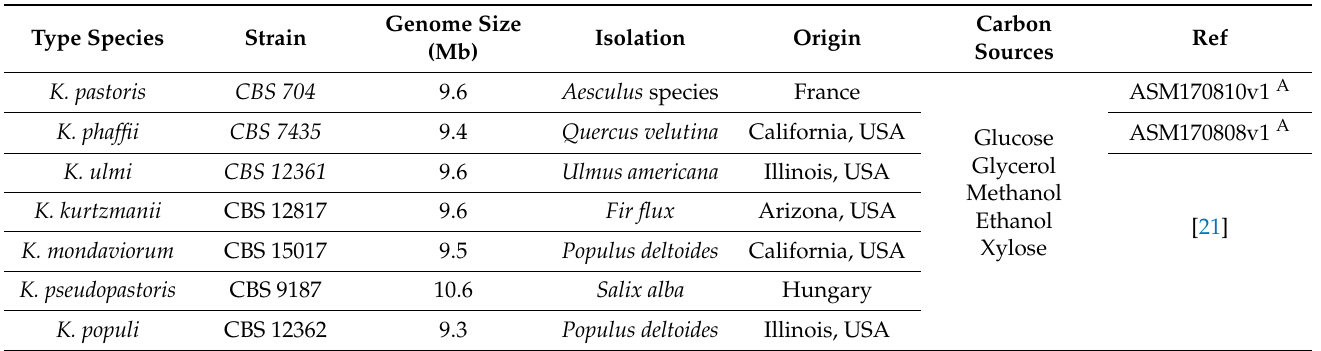
Table 1. Komagataella species diversity and its